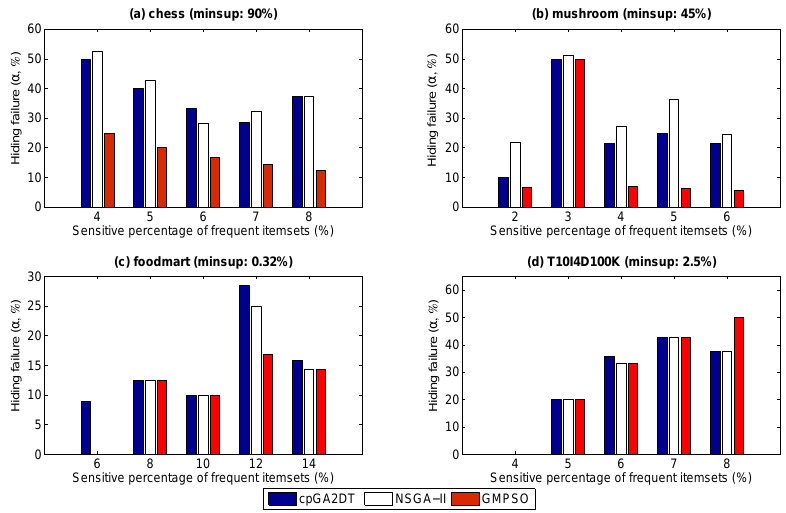
Figure 4. Hiding failure under varied percentages of